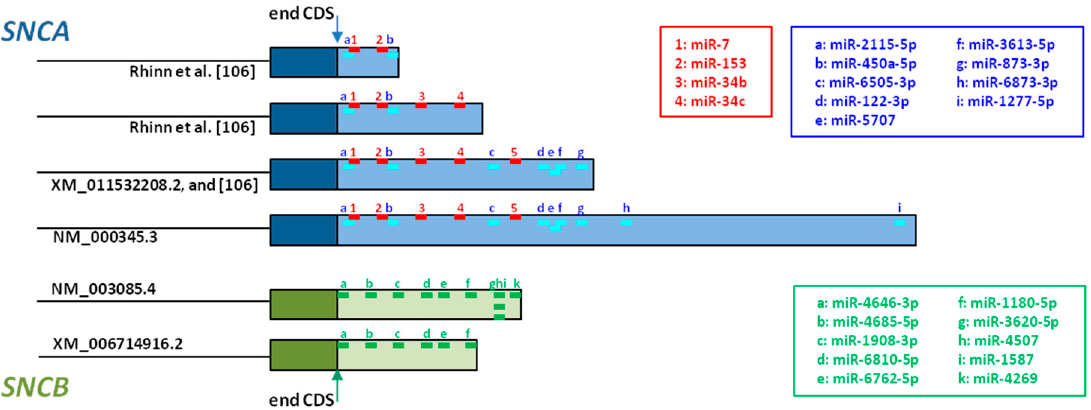
Figure 3. Schematic representation of the 3’UTR of SNCA (blue) and SNCB (green). SNCA and SNCB transcripts that differ in their 3’UTR lengths are shown. Of the four SNCA transcripts, two have been described in the literature, but have not yet been included in the NCBI database. Colored short bars represent the miRNA binding sites, red—experimentally confirmed, blue—predicted for SNCA [178], green—predicted for SNCB , at the same website. CDS: coding sequence.